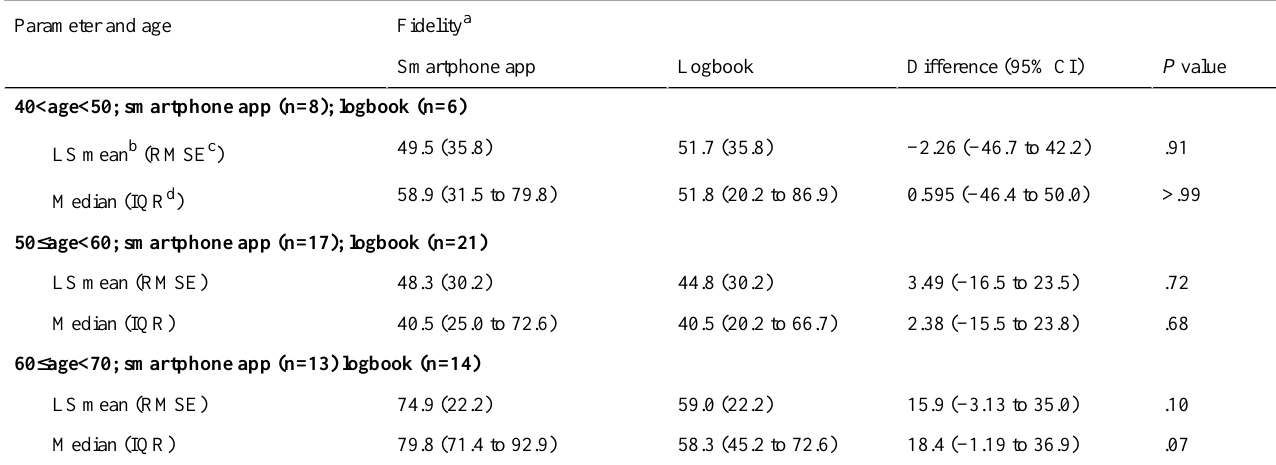
Fidelity a Parameter and age